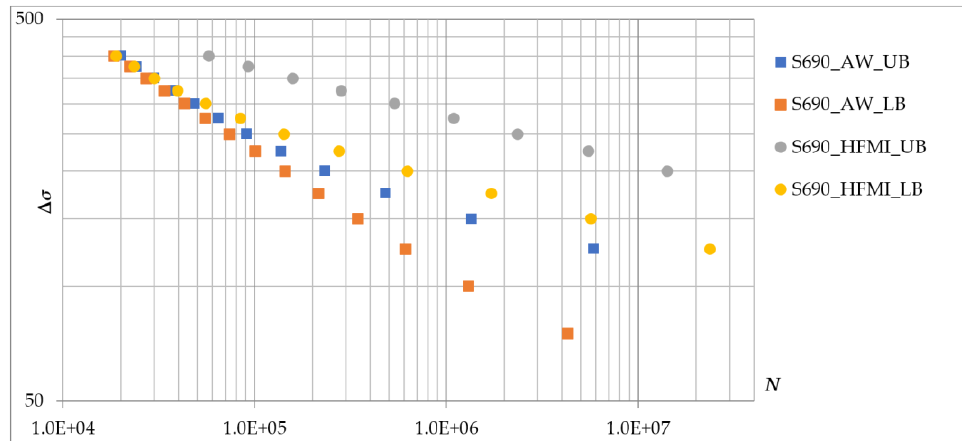
Figure 12. Results of calculated fatigue life for S690 (AW and HFMI condition).